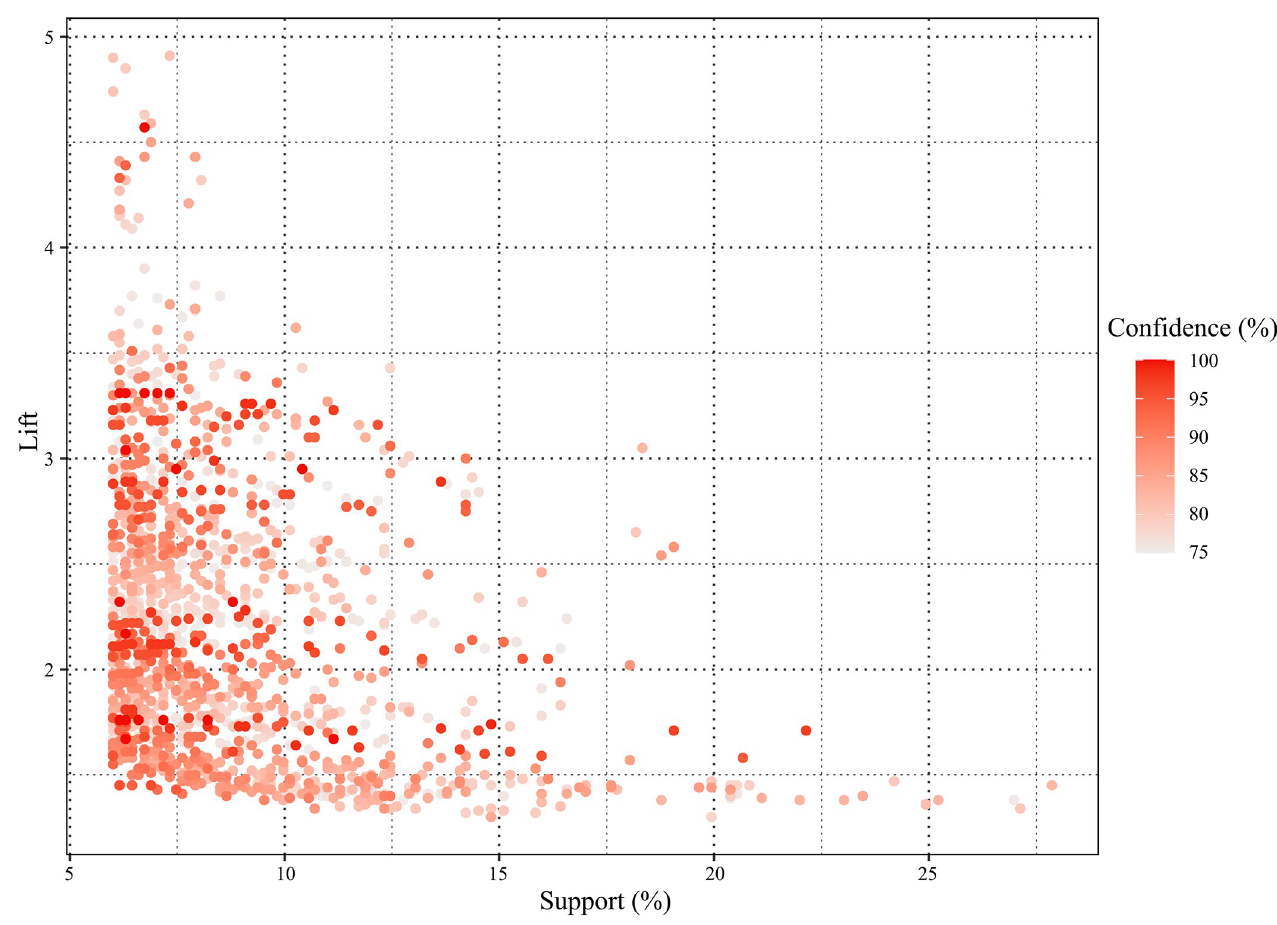
Fig 4. Distribution of lift, support, and